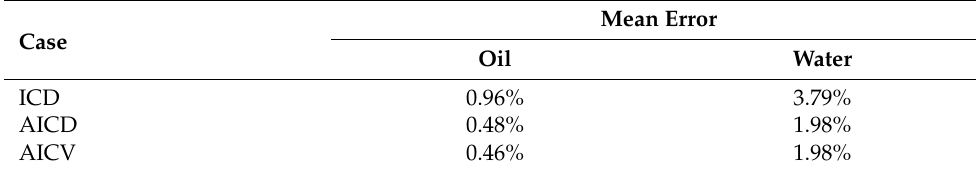
Figure 13. Prediction mean and relative error for the developed proxy models for the ICD, AICD, and AICV cases. Table 3. Prediction mean error for the developed proxy models.